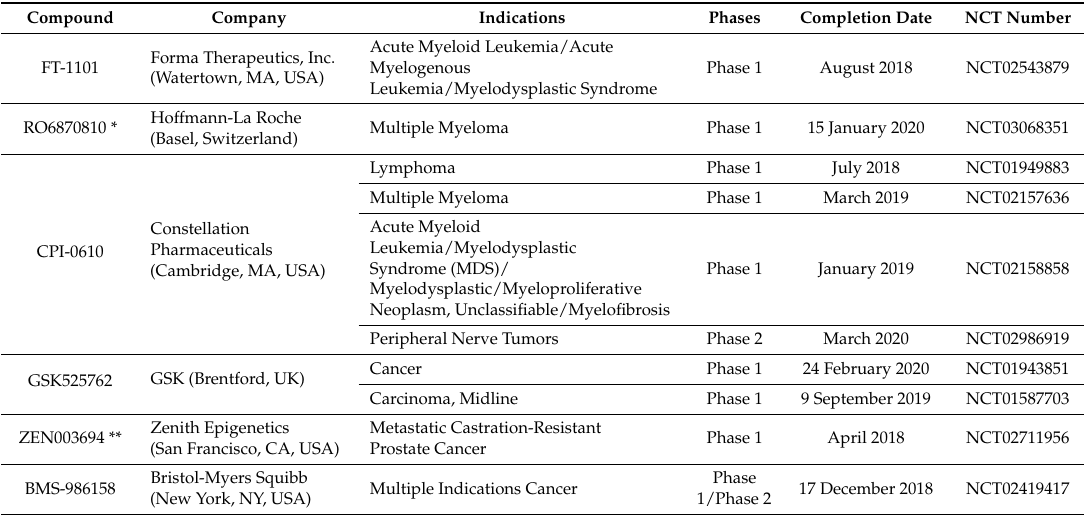
Table 1. Summary of BET inhibitor clinical trials (open Dec.